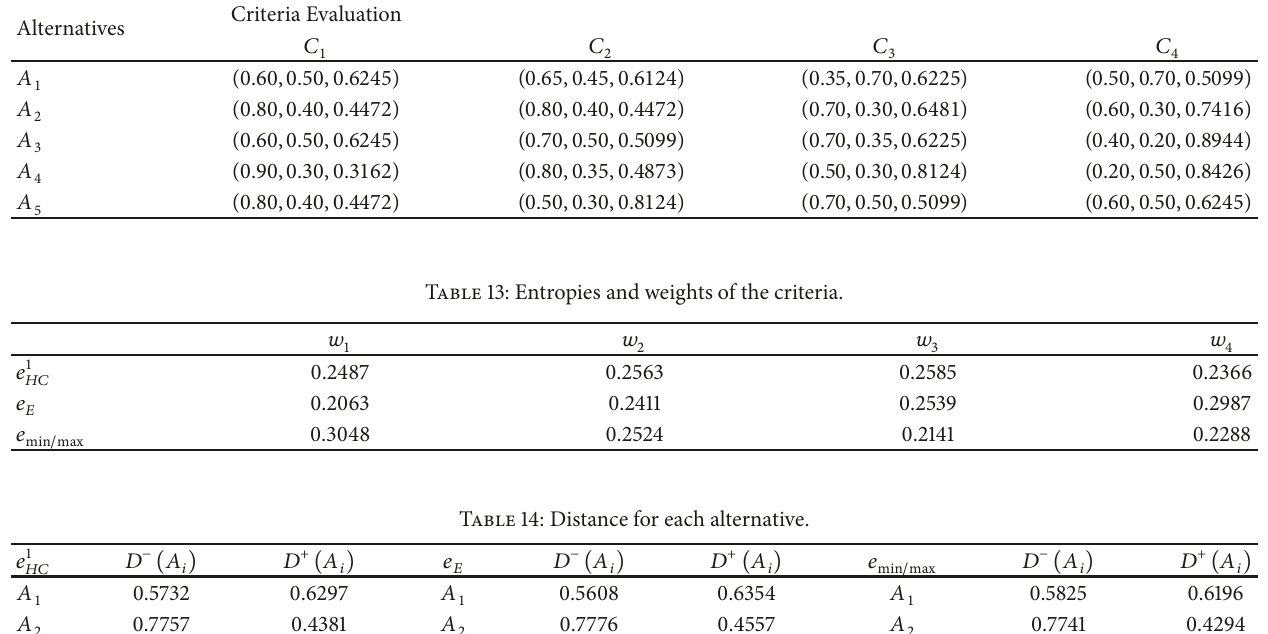
Table 12: Pythagorean fuzzy decision matrix.